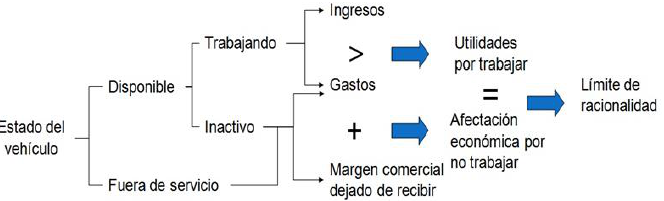
Figura 1: Relación entre el estado de un vehículo y el resultado